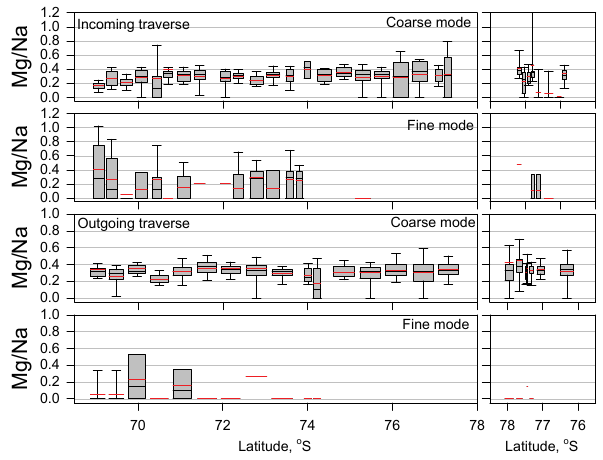
Figure 14. Horizontal features of the atomic ratio of Mg/Na in coarse and fine modes during the incoming traverse. In box plots, the top bar, top box line, black middle box line, bottom box line, and bottom bar respectively denote values of 90, 75, 50 (median), 25, and 10%. The red line shows mean